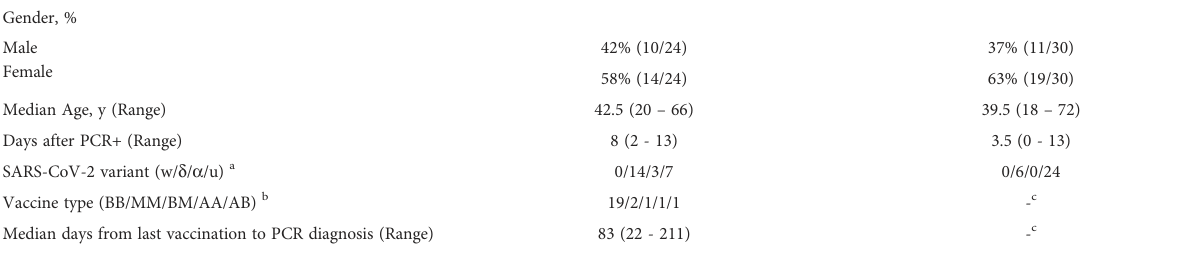
TABLE 1 Basic characteristics of the study